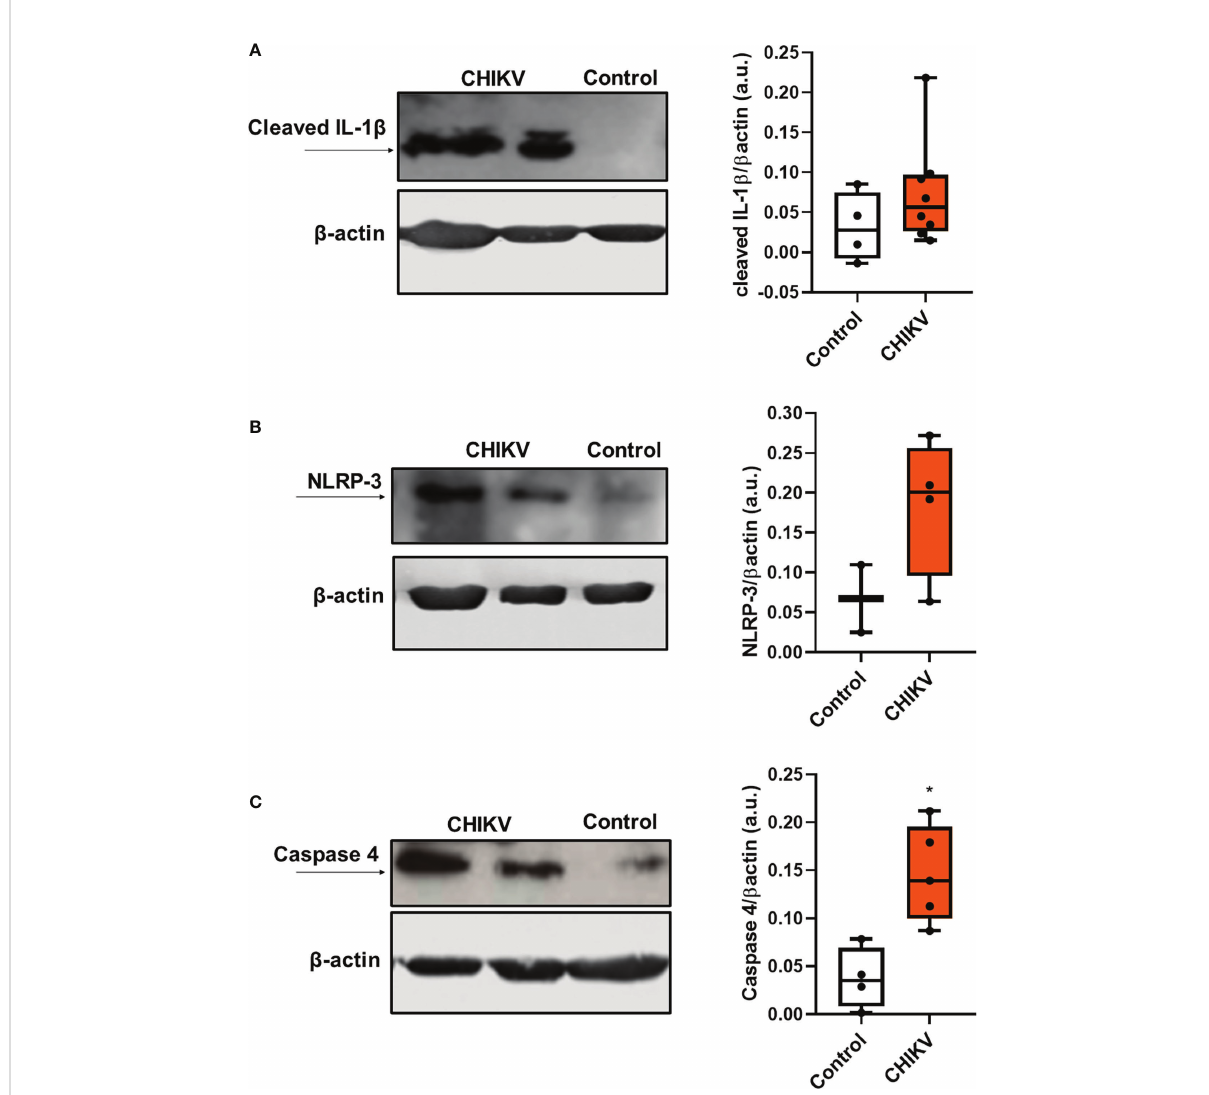
FIGURE 2 Infection with chikungunya virus leads to in fl ammasome activation in platelets. (A) Western blot analysis of cleaved IL-1 b and b -actin expression in platelets isolated from four control subjects and eight CHIKV patients and graph demonstrating band densitometry comparing to CHIKV with Control (NS, p=0.2828); (B) Western blot analysis of NLRP-3 and b -actin expression in platelets isolated from three control subjects and four CHIKV patients and graph demonstrating band densitometry comparing to CHIKV with Control (NS, p=0.2667); (C) Western blot analysis of caspase 4 and b -actin expression in platelets isolated from four control subjects and fi ve patients with CHIKV; and graph demonstrating band densitometry with *P ≤ 0.05 comparing to CHIKV with